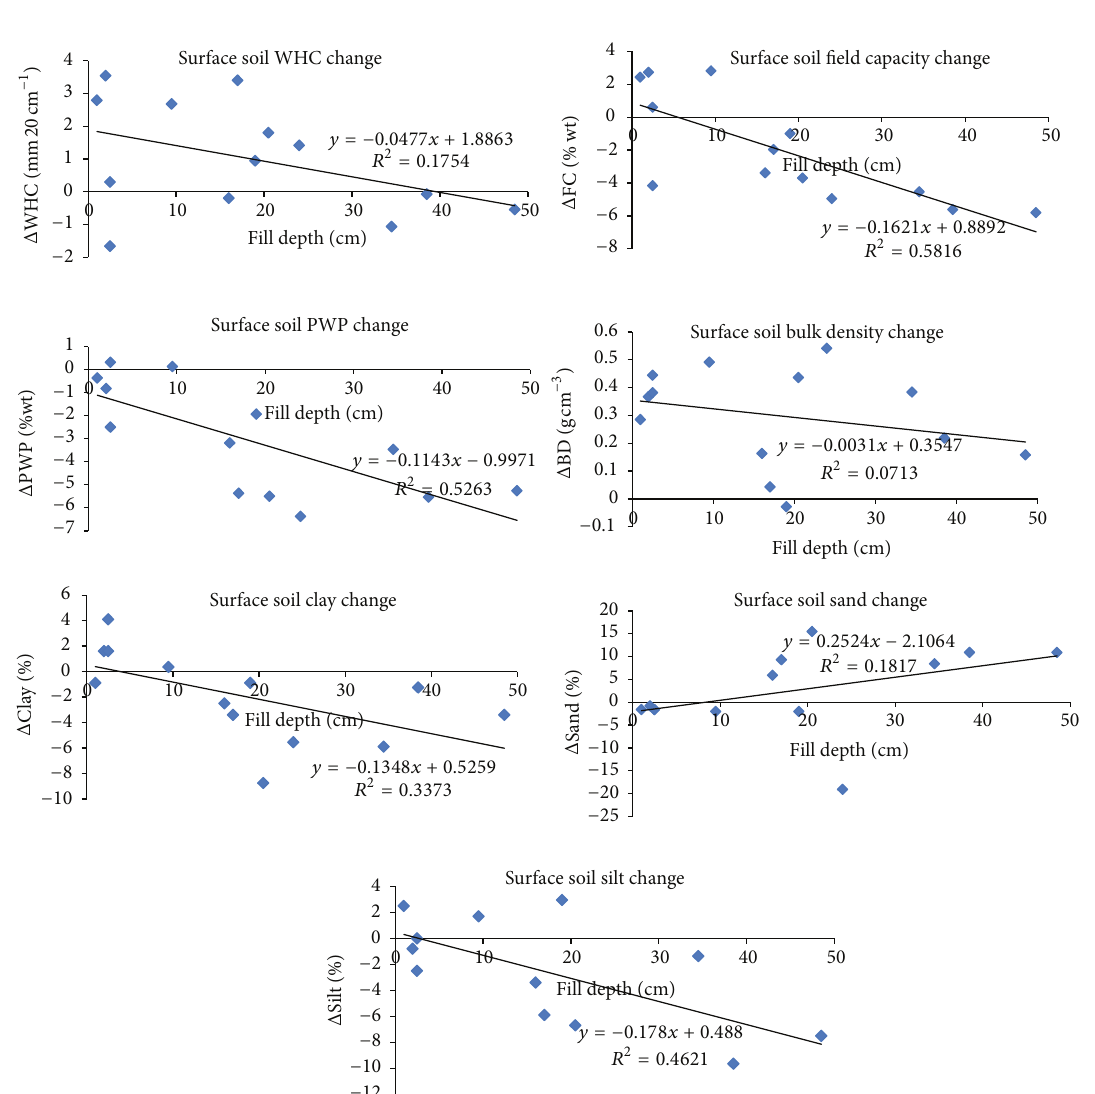
Figure 9: The relationships between the amounts of change of surface soil (0–20cm) physical properties that occurred as a result of leveling and fill depths through fill